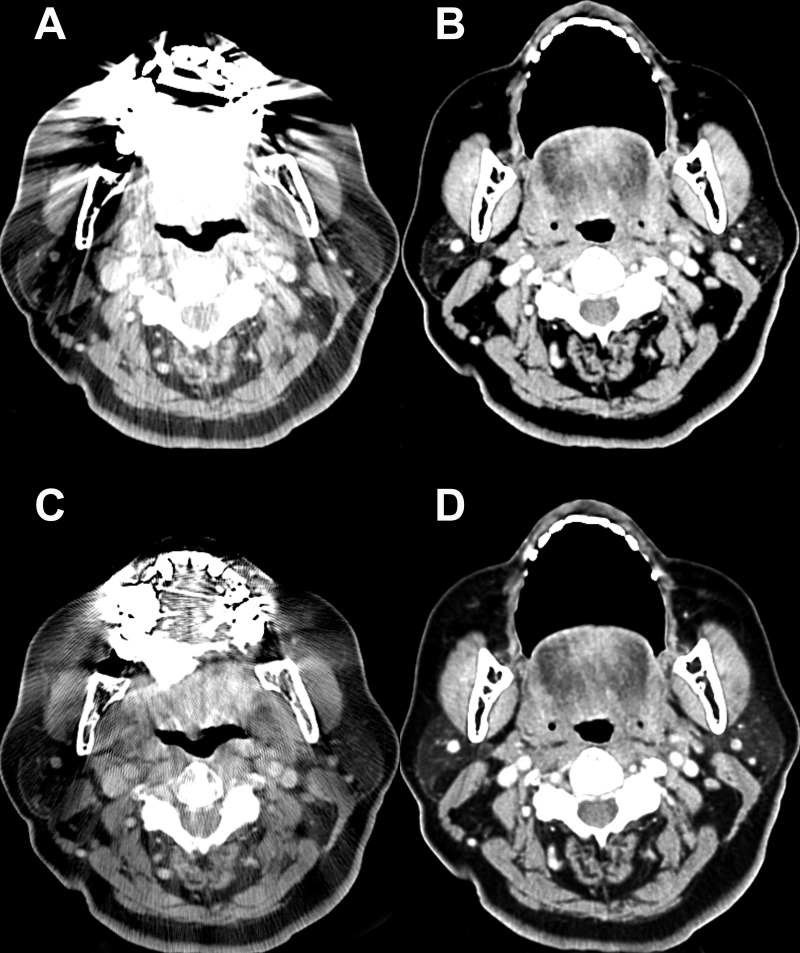
Post-contrast Computed Tomography (CT) images of a 71-year-old woman with a dental prosthesis.Bilateral palatine tonsils are completely covered by the metallic artifact from the adjacent dental prosthesis on a conventional CT image (A). However, on the open mouth CT image (B), there is no streak artifact obscuring the bilateral palatine tonsils, because the axis of the streak artifact from the dental prosthesis is tilted. On a conventional CT image with O-MAR processing (C), the bilateral palatine tonsils are partly seen with decreased artifacts, but the image texture becomes blurry. The added effect of O-MAR is not noticeable on the open mouth CT image with O-MAR processing (D) since the streak artifact is already displaced from the open mouth maneuver. O-MAR = metal artifact reduction for orthopedic implants.